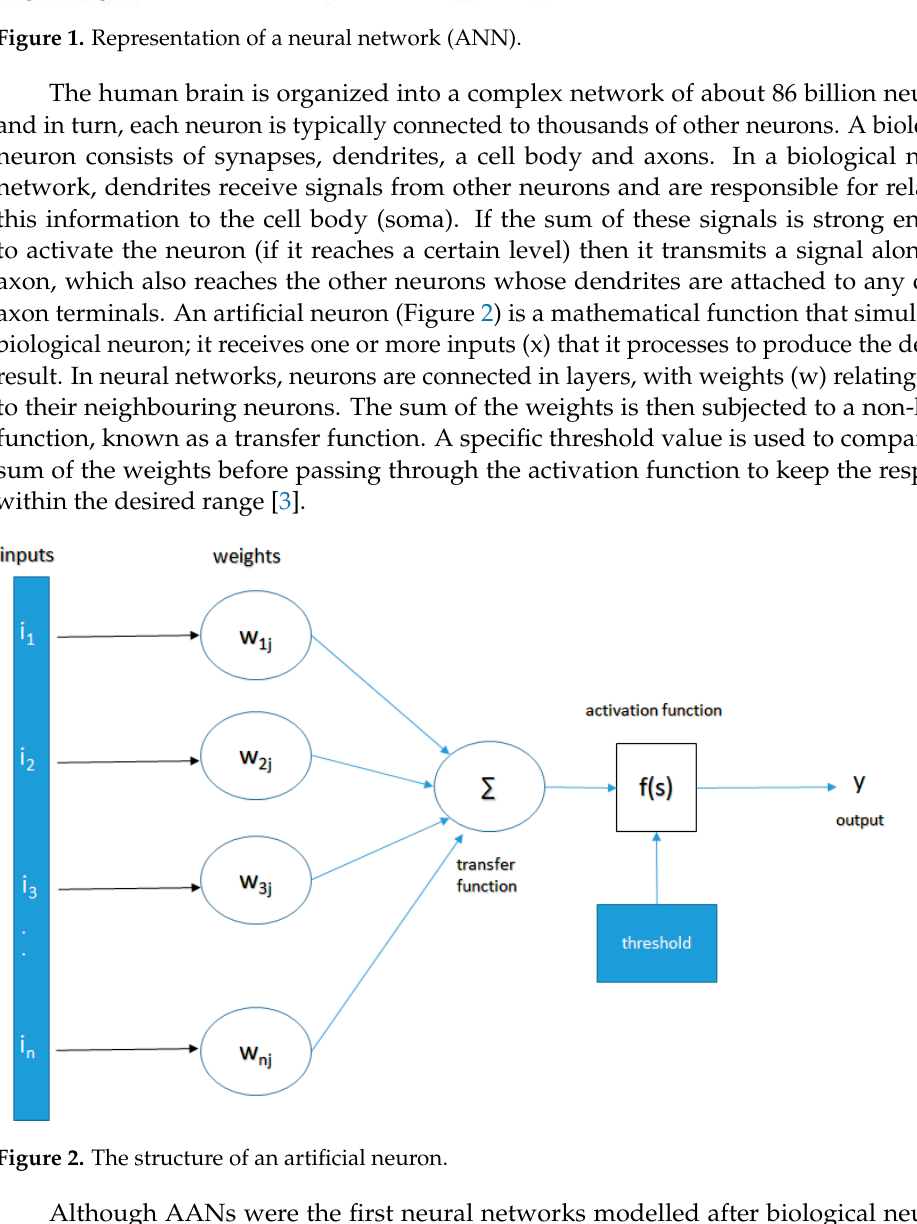
Figure 3. The structure of a deep neural network (DNN). Artificial intelligence is gaining more and more ground through the excellent perfor- mance it has demonstrated in various applications, with the number of AI publications in diagnostic imaging increasing significantly in the past 15 years to more than 1000 per year. The combination of powerful hardware, new techniques and optimized libraries have en- abled the development and use of convolutional neural networks (CNN) in the medical field. Although the shift from expert-based feature determination to data-driven feature learning has been gradual, DL has brought significant improvements over other ML tech- niques in medical image diagnosis. In particular, DL techniques have been investigated for assisting different types of diagnostic modalities (medical imaging and histopatholog- ical diagnosis) as they can help to facilitate the quantitative evaluation of imaging data in